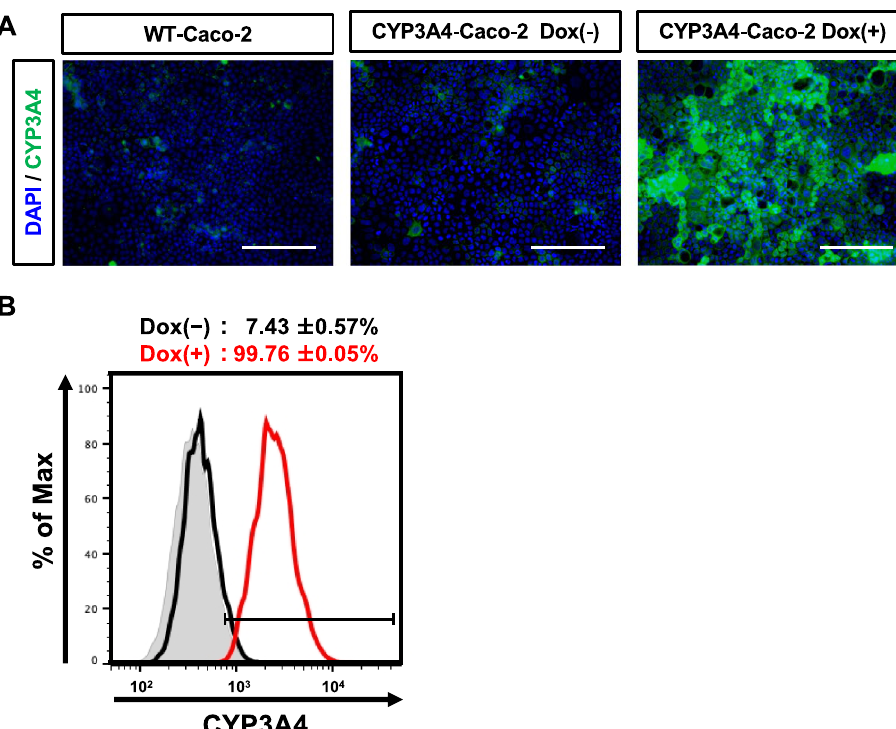
Figure 2. CYP3A4 expression analysis in CYP3A4-Caco-2 cells. The cells were seeded into the 12-well dishes. ( A ) Immunostaining analysis of CYP3A4 (green) was performed in the WT-Caco-2 cells and CYP3A4- expressing Caco-2 cells (#1) with or without Dox treatment (Dox (+) and Dox (−)). Nuclei were stained with DAPI (blue). Scale bar represents 200 μm. ( B ) The percentage of CYP3A4-positive cells in CYP3A4-Caco-2 cells (#1) with or without Dox treatment (Dox (+) and Dox (−)) was examined by FACS